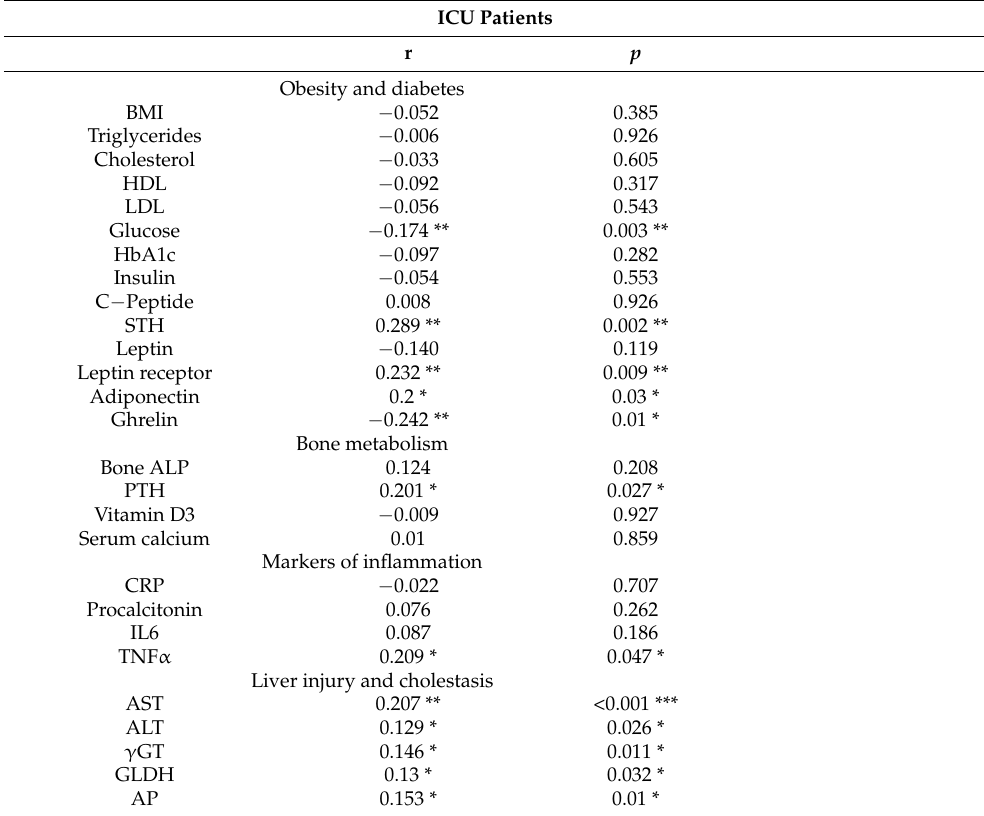
Table 3. Correlations of sRANKL with baseline characteristics, laboratory markers and clinical scores at ICU admission